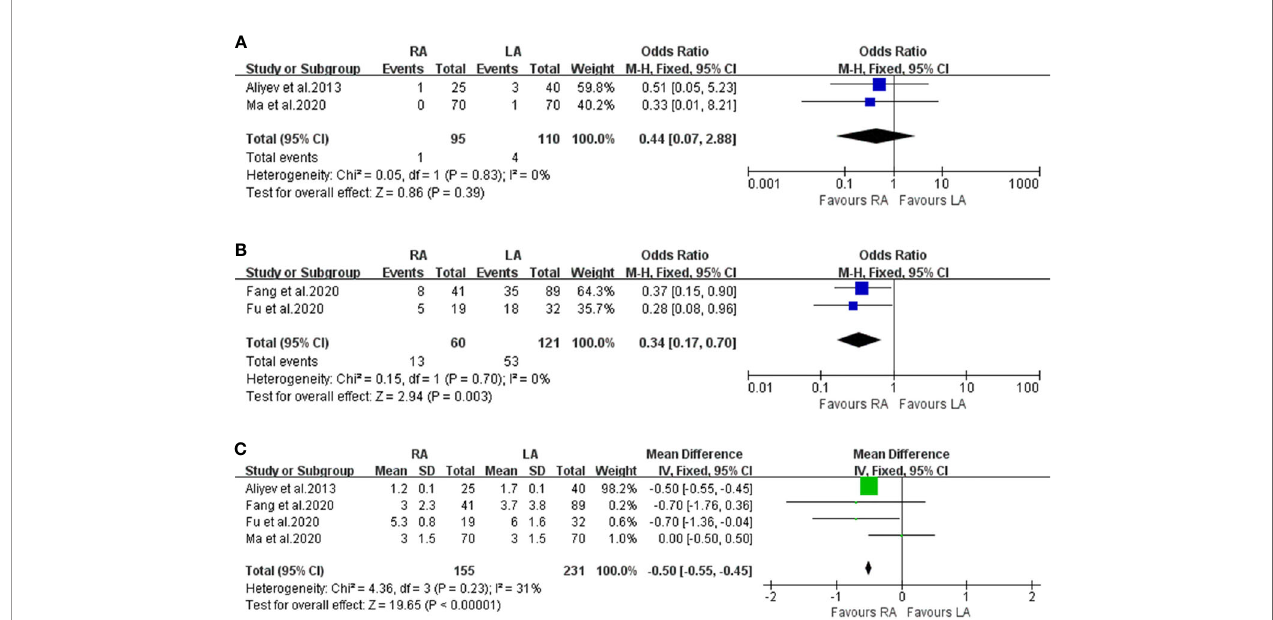
FIGURE 3 | Forest plots of perioperative outcomes: (A) conversion rate, (B) intraoperative hemodynamic instability, (C) length of hospital stay.